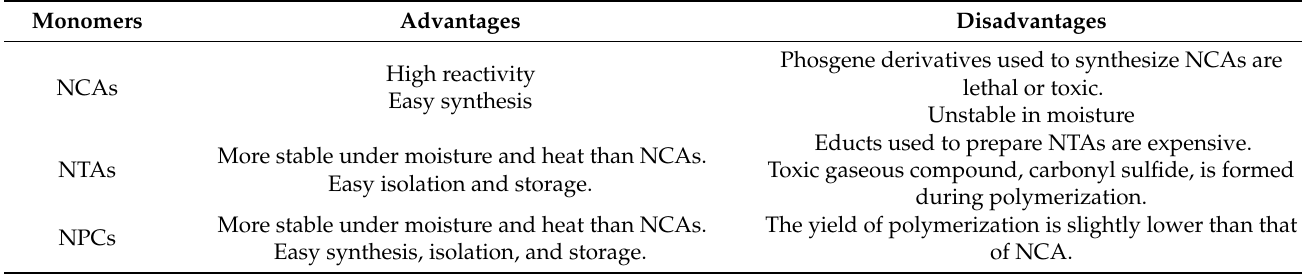
Table 1. Pros and cons of different monomers.